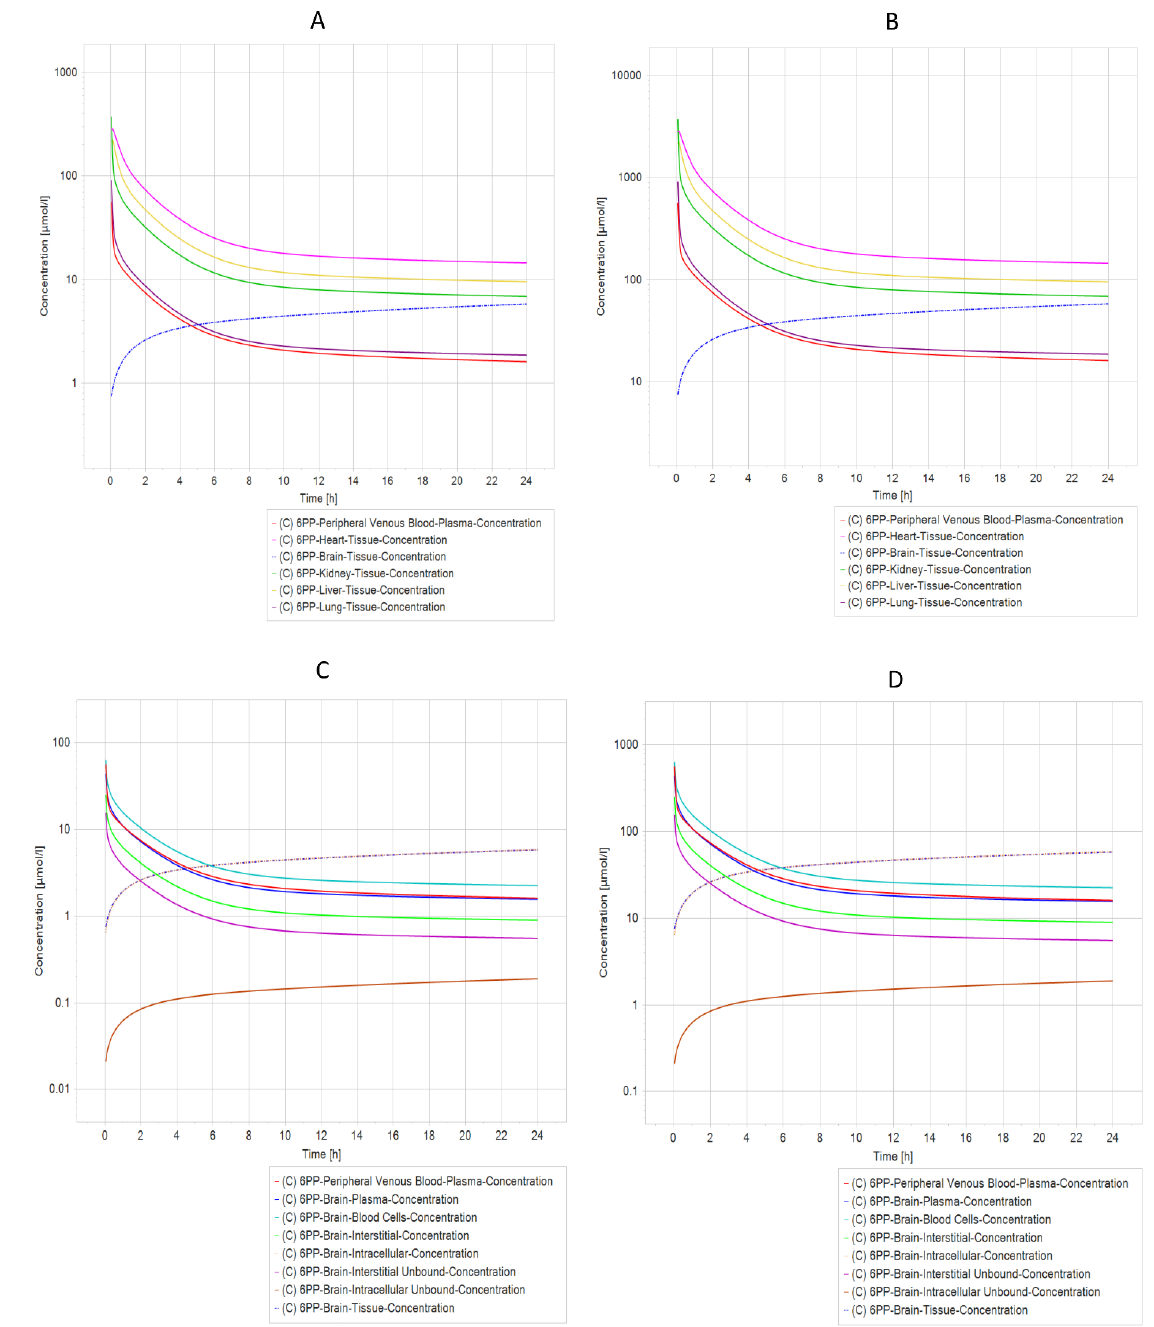
Figure 7. PBPK Model comparison of different model simulations across different dosages of 6 APP molecules modeled in a healthy individual. ( A ) Five different compartments (organs) dosed with 10 mg/kg in a healthy individual. ( B ) Five different compartments dosed with 100 mg/kg in a healthy individual. ( C ) Different brain compartments dosed with 10 mg/kg in a healthy individual. ( D ) Different brain compartments dosed 100 mg/kg in a healthy individual. The heart, liver, and kidney are the organs that have the longest elimination time of molecule 6 APP, whereas ( C , D ) (Brain) have an increase in the concentration of molecule 6 APP in tissue and intracellular compartments.